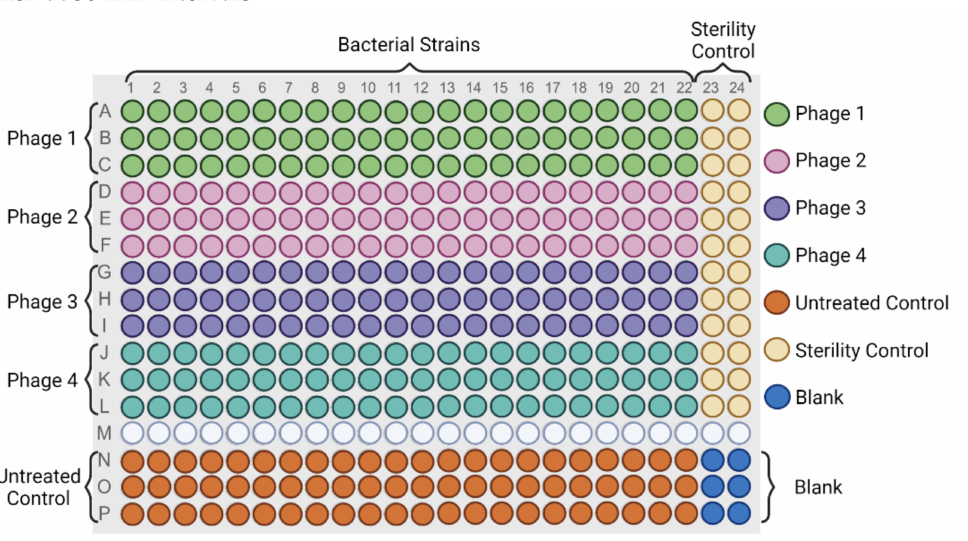
Figure 2. The 384-well plate layout for the high throughput turbidimetric host range determination assay. Columns indicate the number of bacterial strains, and rows, the treatments. Phages 1–4 indicate different phages tested in technical triplicates (50 µ L of bacteria dilution + 50 µ L of phage dilution). Untreated control (50 µ L of bacteria dilution + 50 µ L of CM buffer). Sterility control (50 µ L of 2 x media + 50 µ L of phage dilution). Blank (50 µ L of 2 x media + 50 µ L of CM buffer). Created with